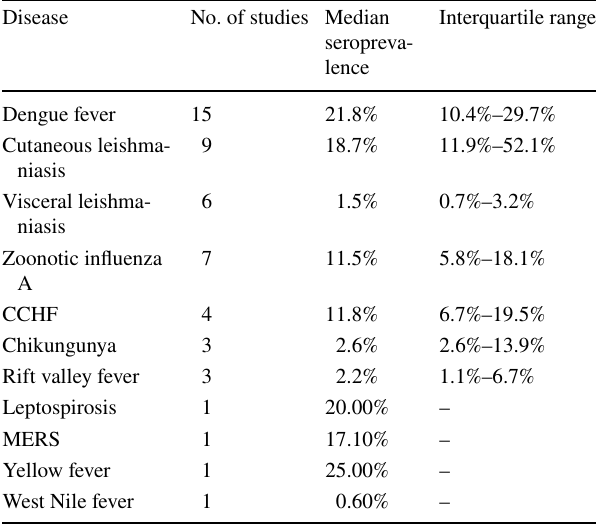
Table 2 Seroprevalence rates of vector-borne and zoonotic diseases in the Eastern Mediterranean